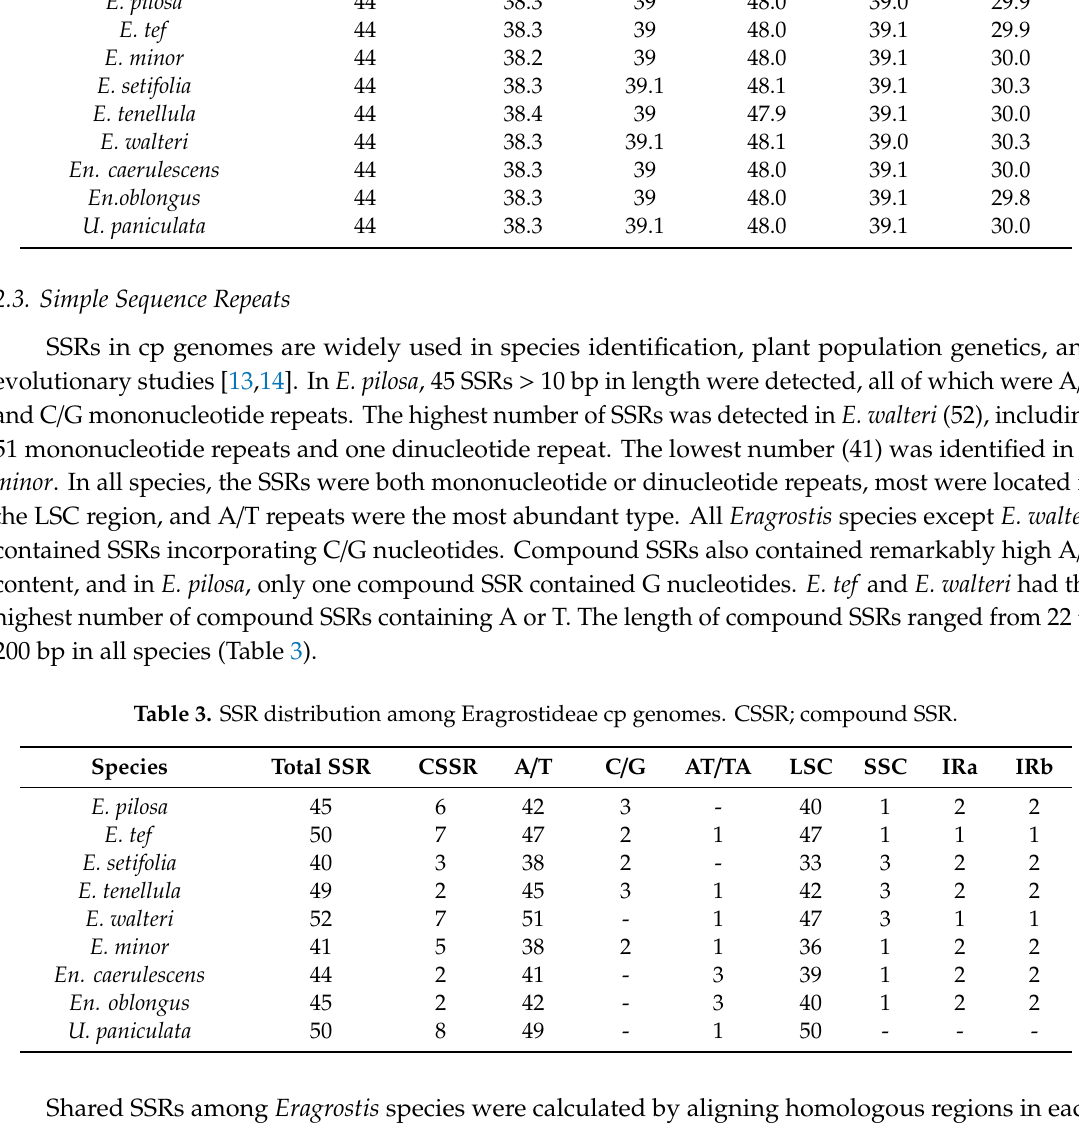
Table 2. GC content of the Eragrostideae cp genome sequences. GC content (g) whole cp genome (c) 44 analyzed CDS (1) (2) (3) first, second, and third codon positions, respectively. Species Analyzed CDS